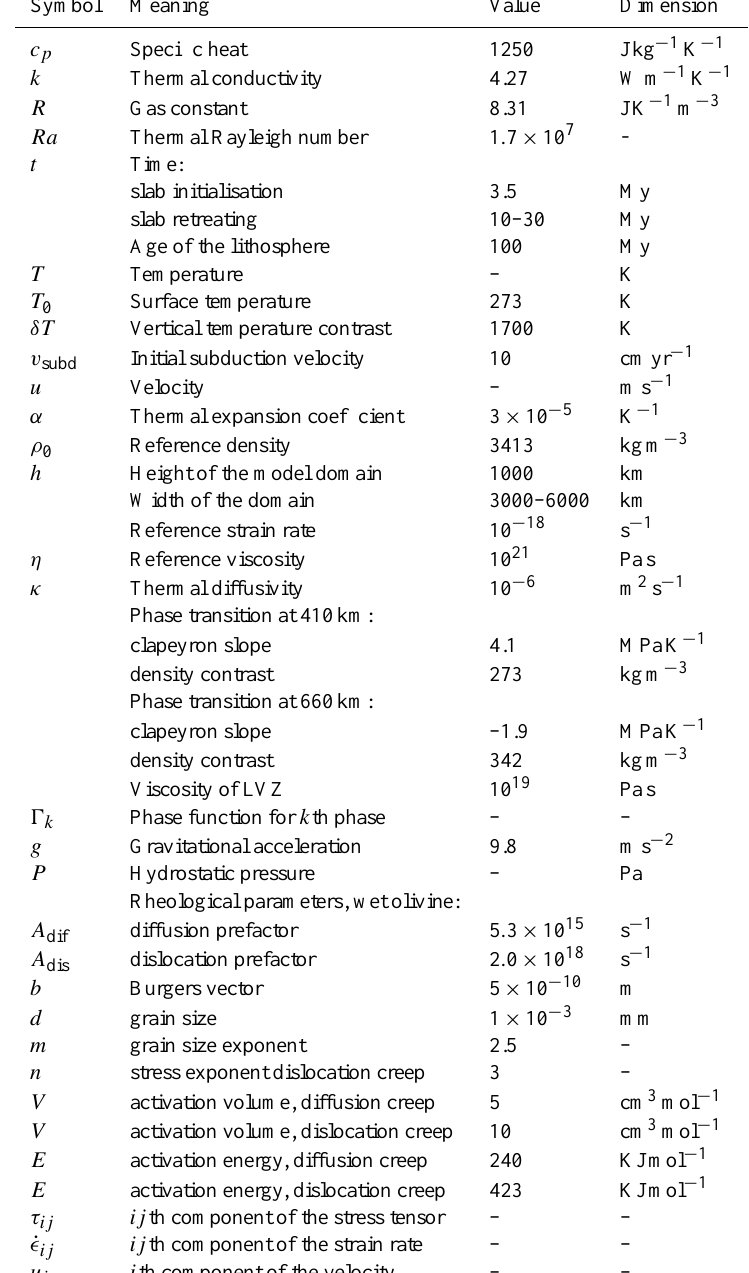
Table 1. Parameters of the